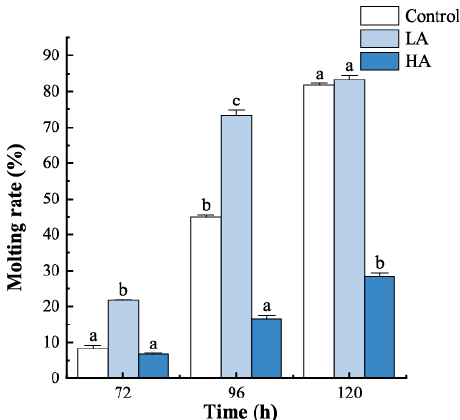
Figure 2. Molting rate of juvenile P. trituberculatus at different ammonia nitrogen concentrations. At the same time, the letters indicate significant differences between experimental groups ( p < 0.05).